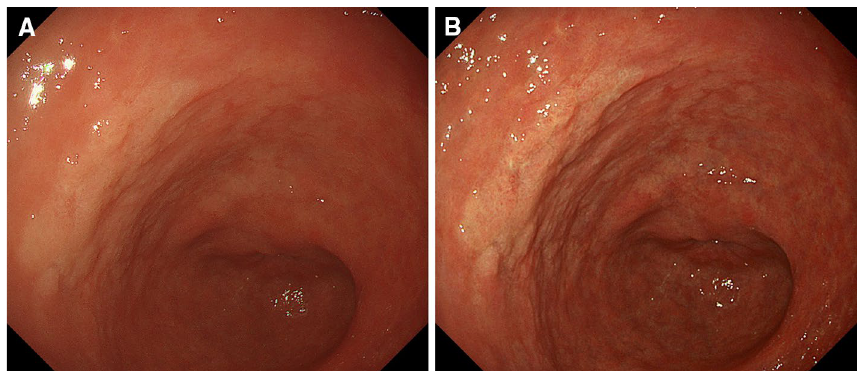
Figure 3. A representative case showing improved color differences on TXI. ( A ) WLI displayed a slightly discolored, flat elevated lesion in the anterior wall of the lower gastric body. The demarcation line is slightly difficult to identify. The mean ΔE was 8.5 ± 1.6. ( B ) TXI displayed contrast enhancement between the lesion and the surrounding mucosa, resulting in an easily recognizable demarcation line. The mean ΔE was 12.7 ± 4.3.